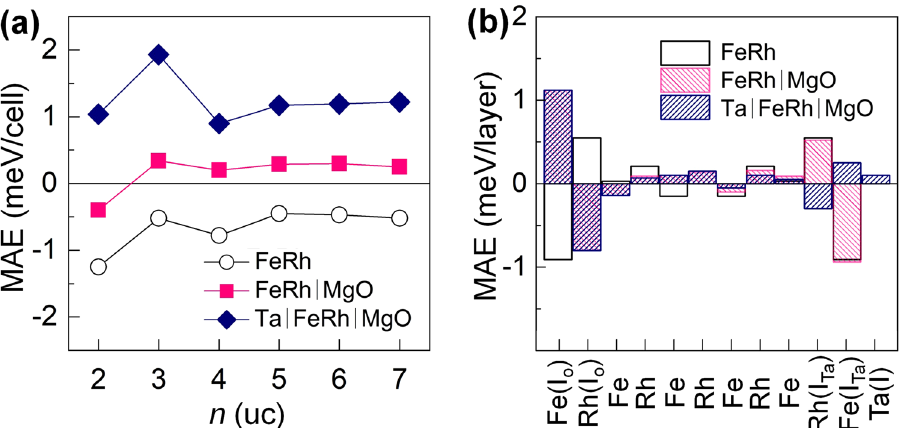
Figure 4. ( a ) Magnetic anisotropy energy (MAE) versus the number of FeRh unit cell layers ( n ) for FeRh (open black circles), FeRh/MgO (filled red squares), and Ta/FeRh/MgO (filled blue rhombi) multilayers. ( b ) Layer- resolved MAE for FeRh layers for FeRh (open black bars), FeRh/MgO (filled red bars), and Ta/FeRh/MgO (filled blue bars) multilayers with n = 5 uc . In ( b ), the letters I O and I Ta denote the interfaces next to the MgO and Ta layers,